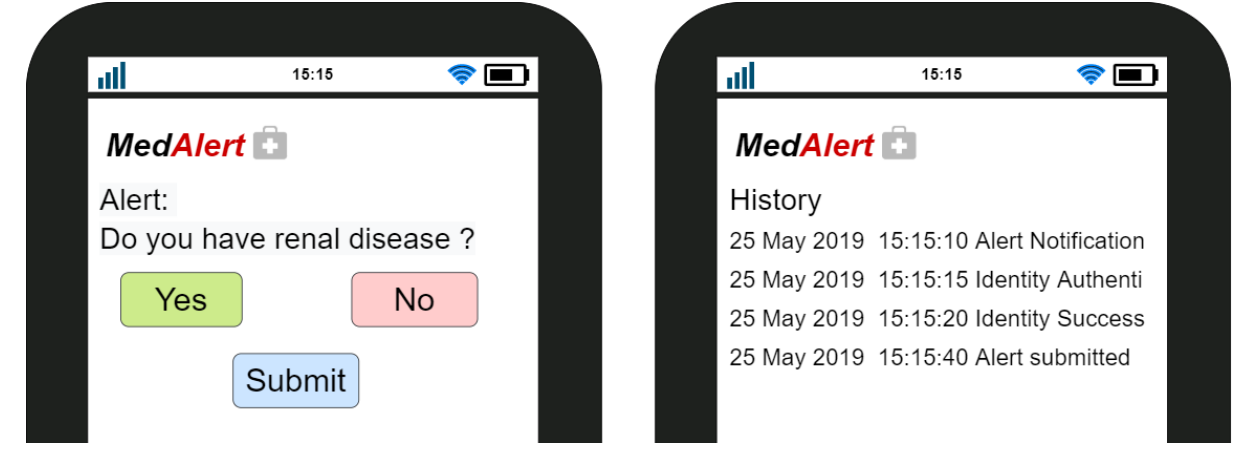
Figure 8. Question in alert (left) and history log of patients (right).